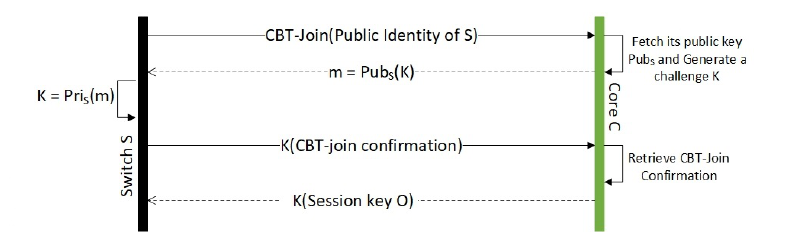
Figure 1. CBT-Join for switches that are one hop away from a core node.